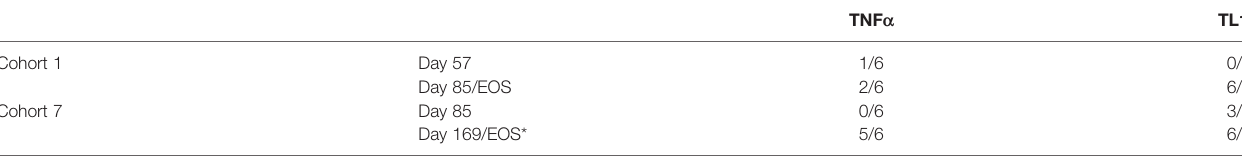
TABLE 2 | Incidence of anti-AMG 966 neutralizing antibodies to the TNF a and TL1A binding domains.